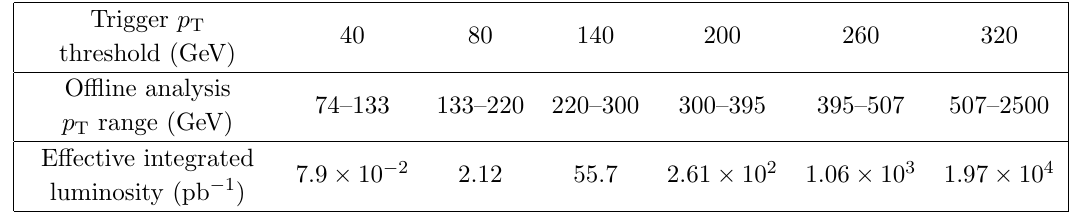
Table 1 . HLT trigger ranges and e(cid:11)ective integrated luminosities used in the jet cross section measurement. The luminosity is known with a 2.6%